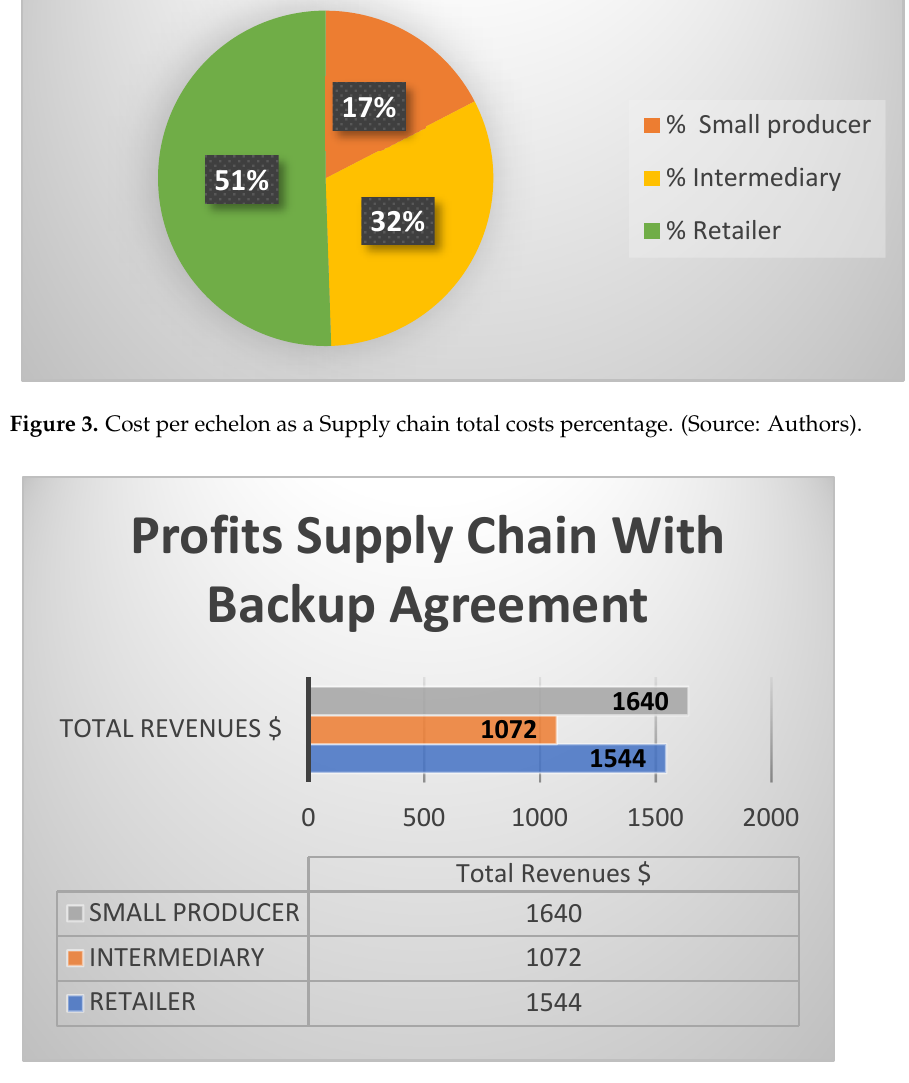
Figure 4. Supply Chain profits with backup agreement. (Source: Authors). According to the results (See Table 1), profits increase in the downstream supply chain. The less profit generated in the small producer echelon can be evidenced. The absence of supply chain integration is a potential cause, where the small producer is subject to the intermediary and retailer conditions in price and order quantity terms among others. Table 1. Chain profit results without backup